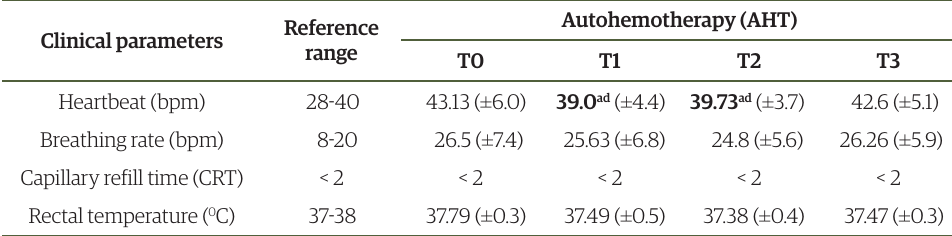
Table 1. Clinical parameters of the horses submitted to autohemotherapy over